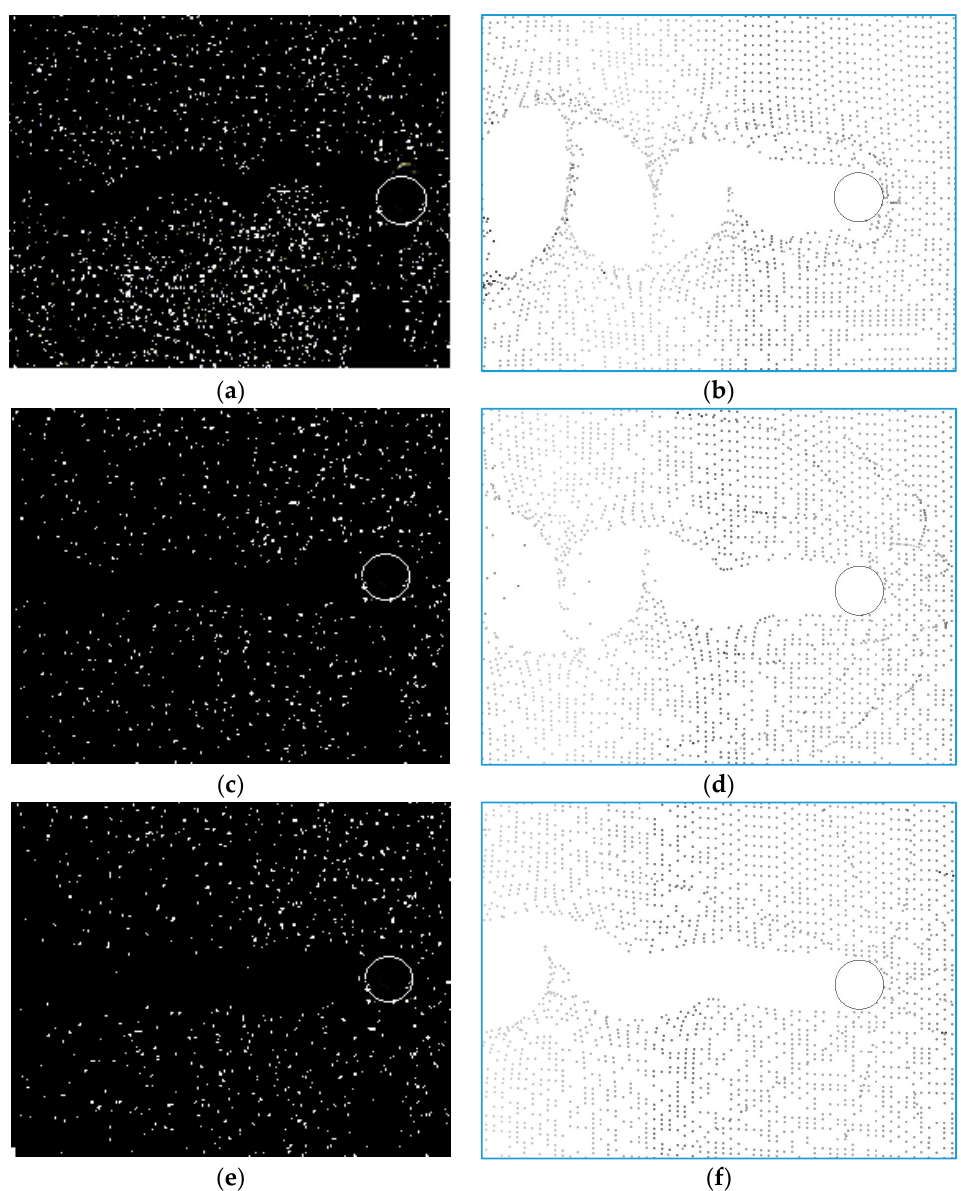
Figure 5. Particle dispersion pictures at three St numbers: ( a ) Experiment at St = 0.98; ( b ) computation at St = 0.98; ( c ) experiment at St = 6.5; ( d ) computation at St = 6.5; ( e ) experiment at St = 19.7; ( f ) computation at St = 19.7.